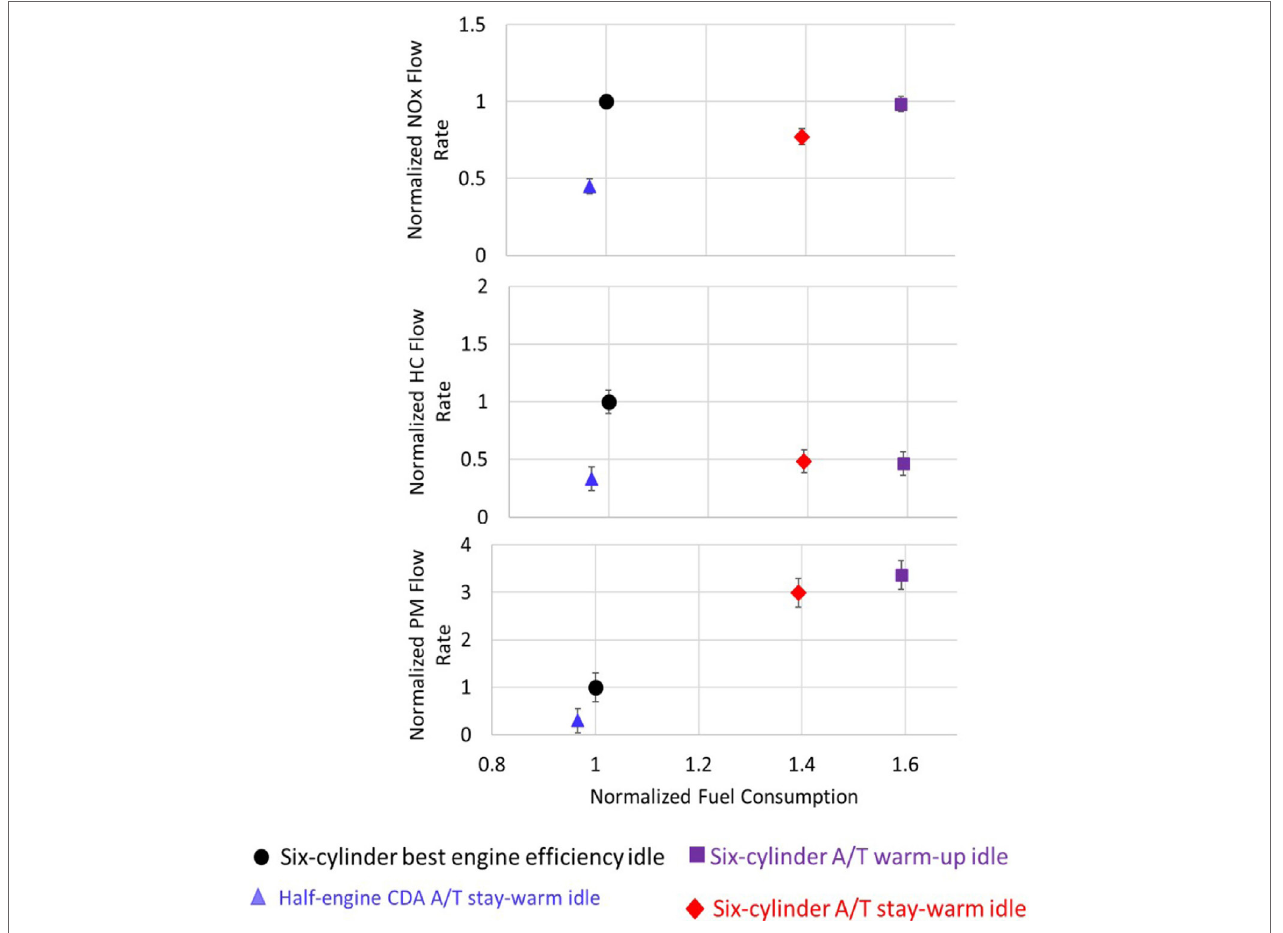
FigUre 12 | Experimental emissions results for each of the four strategies at 800 RPM/1.3 bar.